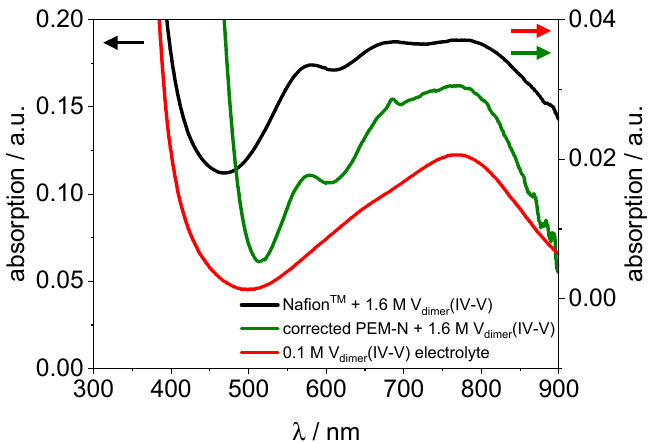
Figure 12. UV/VIS spectra of the PVDF-based membrane hydrated with V dimer (IV–V) (corrected), Nafion™ hydrated with V dimer (IV–V) and 0.1 M V dimer (IV–V)